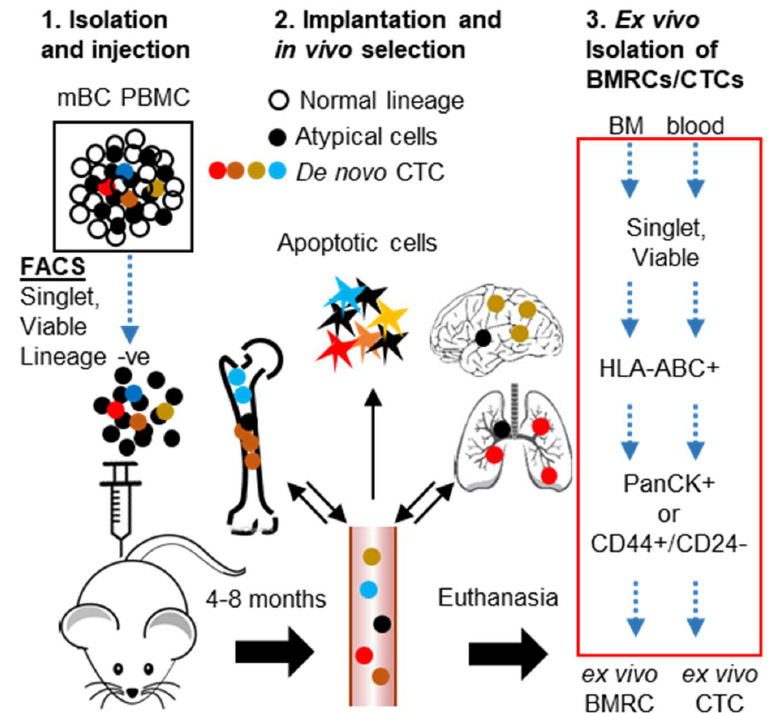
Figure 1. Strategy for in vivo enrichment of mBC patient-derived CTCs and isolation of ex vivo BMRCs and CTCs. This strategy employs: 1. Doublet and dead cell removal, followed by lineage